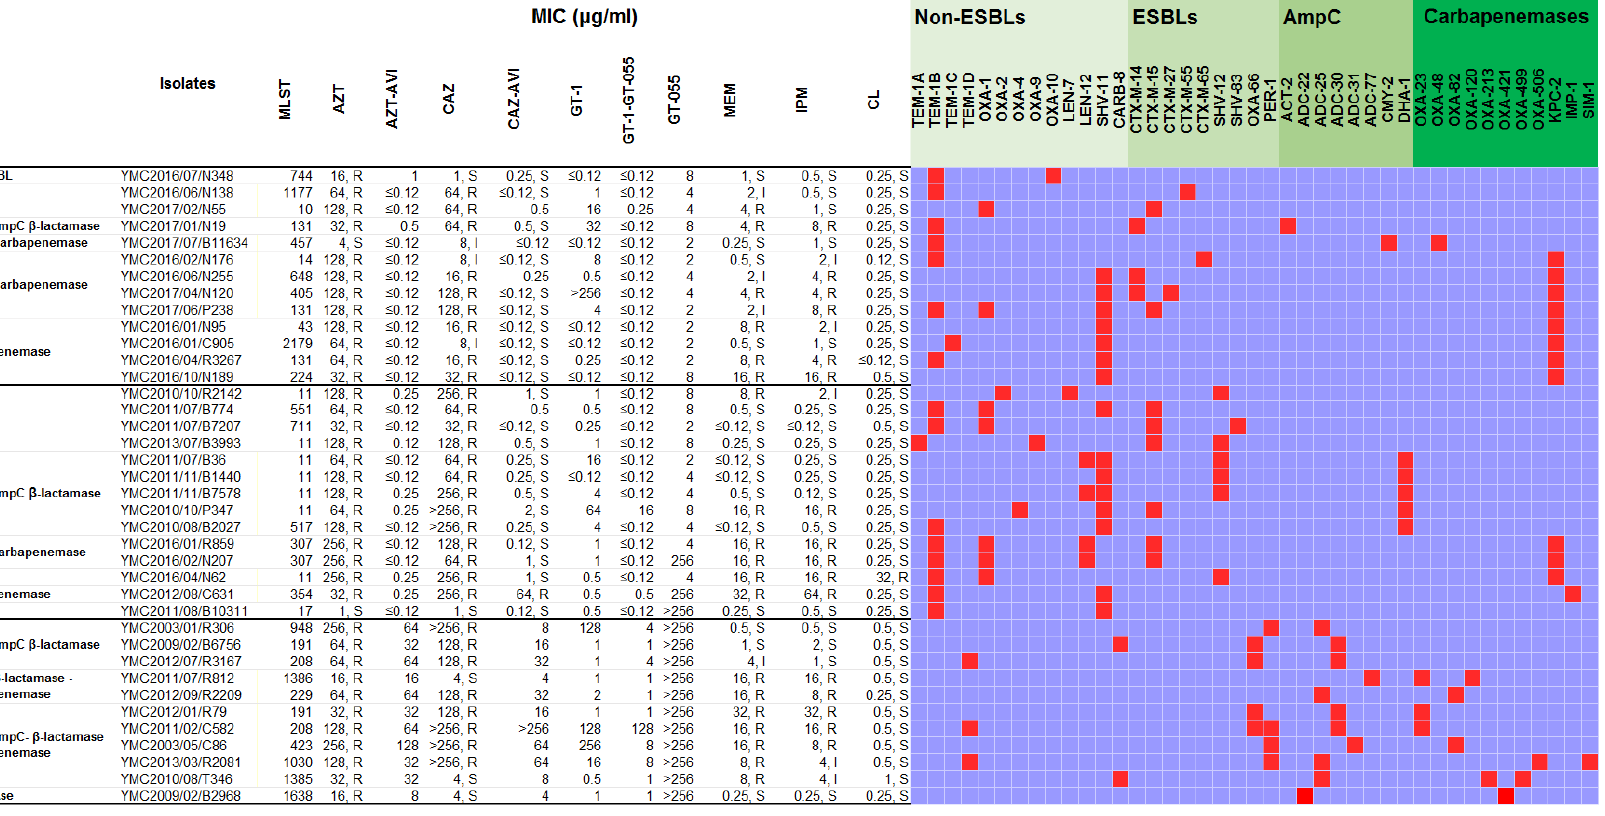
Table 1. Antibiotic susceptibility and resistome of the Escherichia coli , Klebsiella pneumoniae and Acinetobacter spp. panel